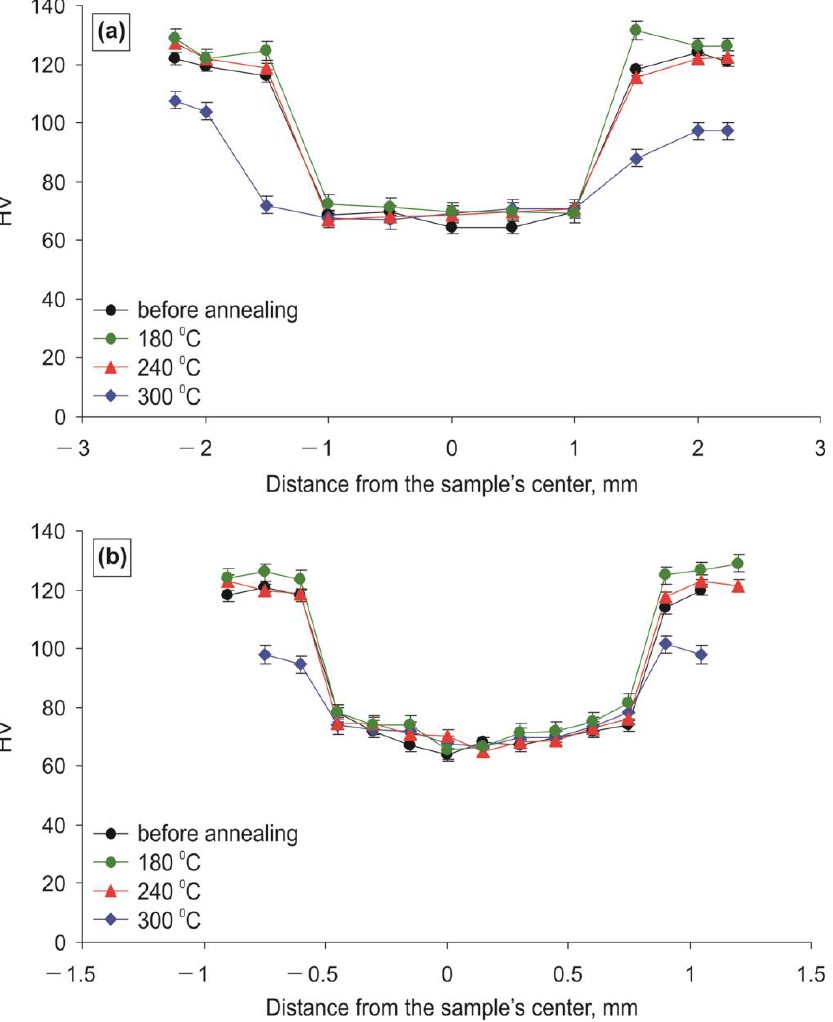
Figure 11. Microhardness value distribution in the cross section of the composite sample with a diameter of ( a ) 5 mm ( e = 2.77) and ( b ) 2.5 mm ( e = 4.16), depending on the annealing temperature.